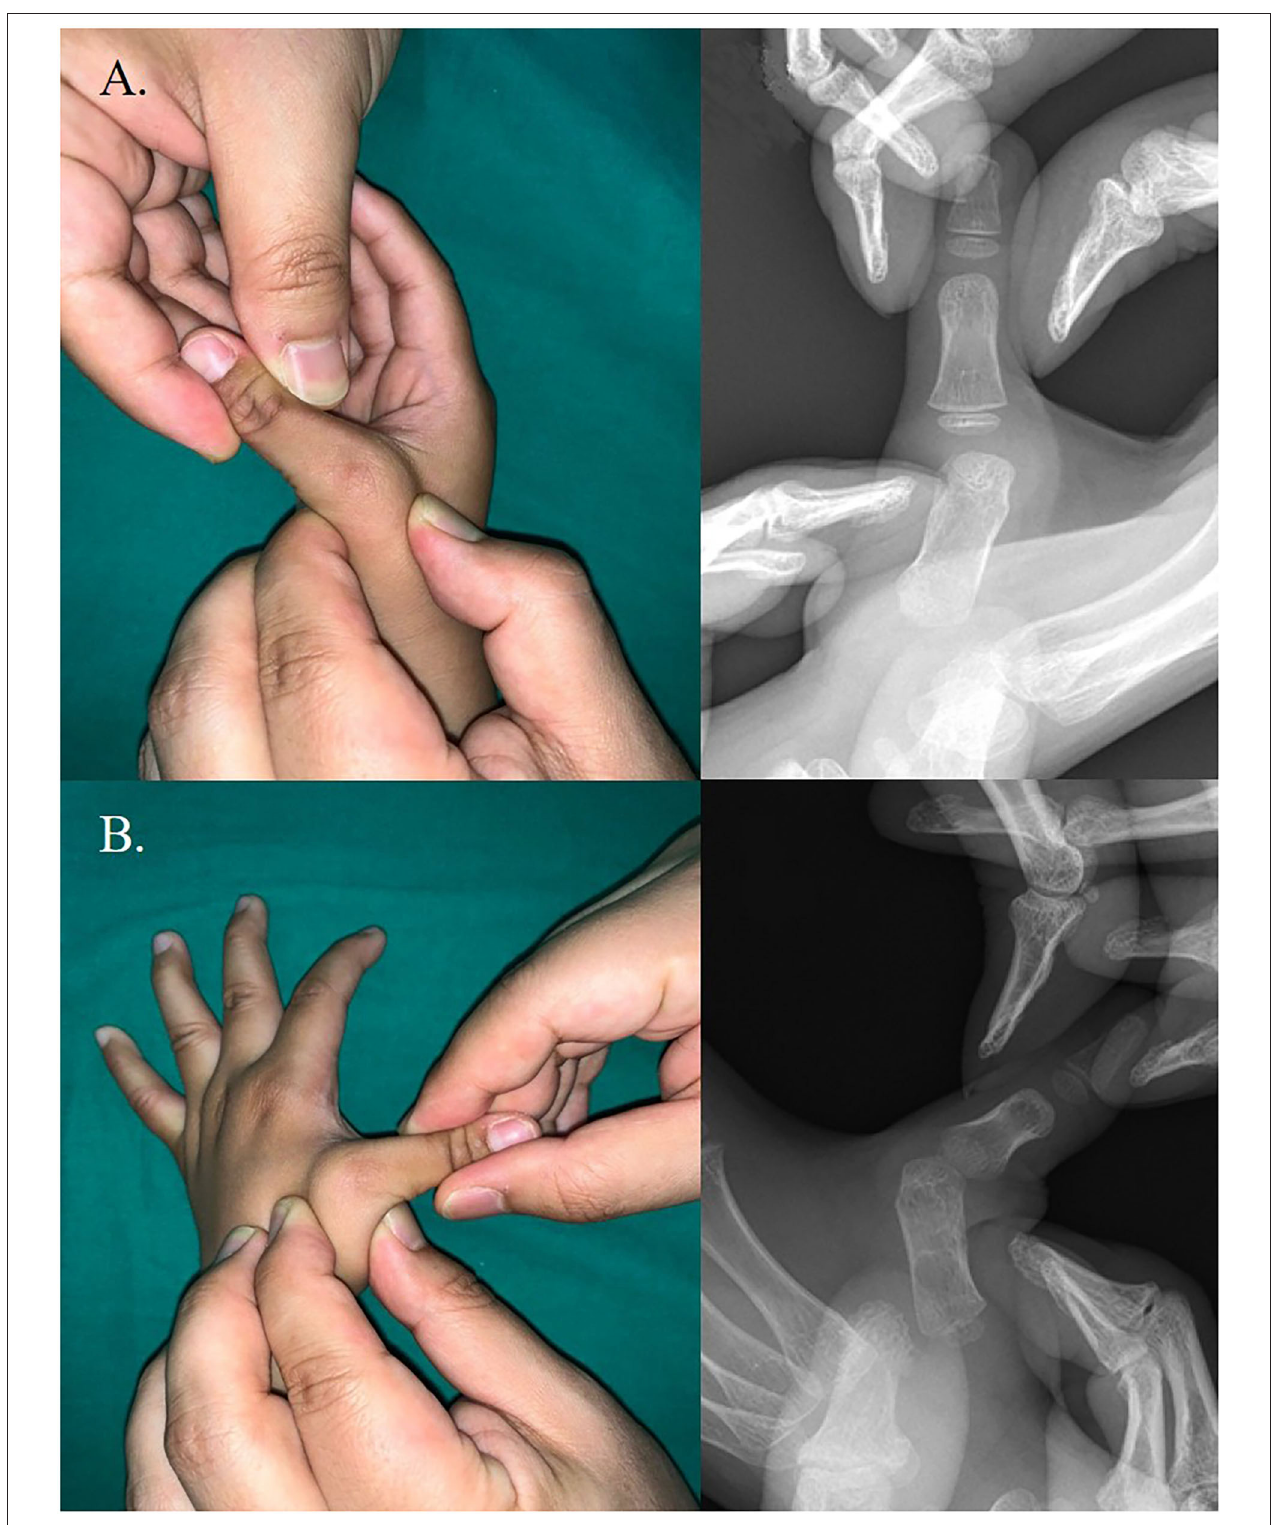
FIGURE 2 | Metacaropophalangeal joint instability on stress test. (A) Right thumb. (B) Left thumb. A markedly unstable metacarpophalangeal joint was noted in left thumb.